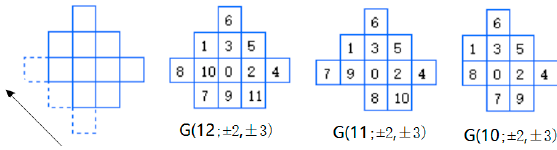
Figure 8. Deleting vertices from G d .